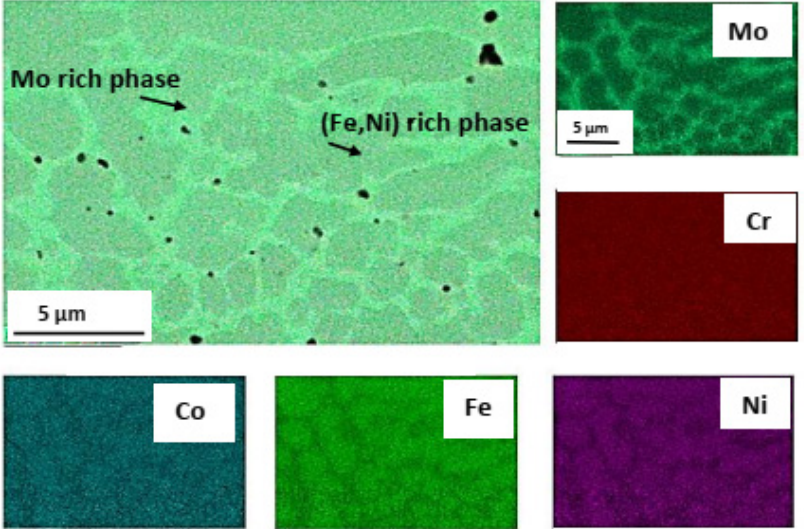
Figure 5. Pores (entrapped gas bubbles) were preferably observed in the Mo-rich phase in the Mo-HEA coating. Porosity appears to be localized in the bulk of the coating, but smaller pores were observed in the area closer to the substrate, as seen in Figure 6.